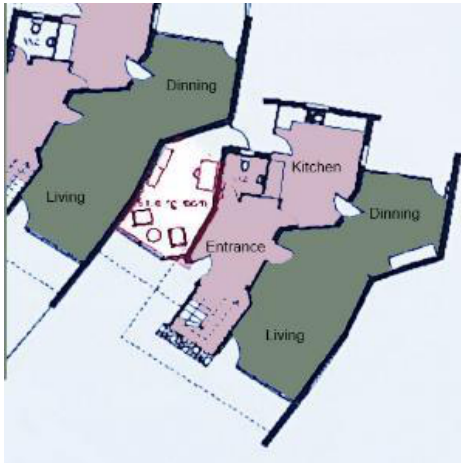
Figure 16. Efruz House Type3, Open Plan (Esentepe, 2013).